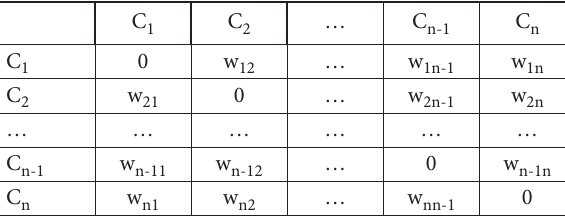
Table 2. Example of an adjacency matrix